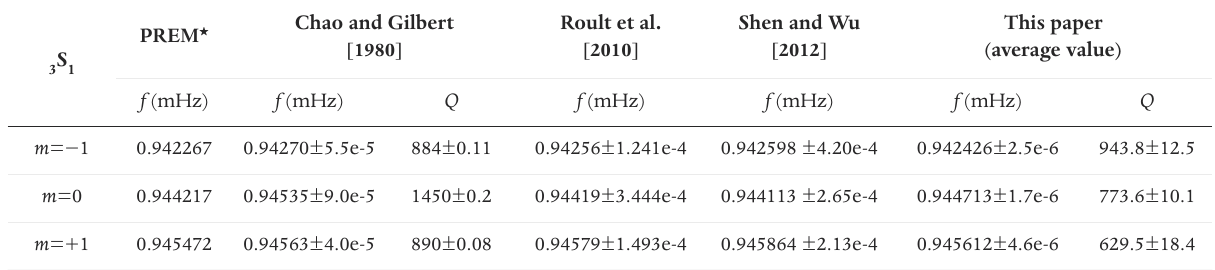
S . (*): from Roult et al. 3 1